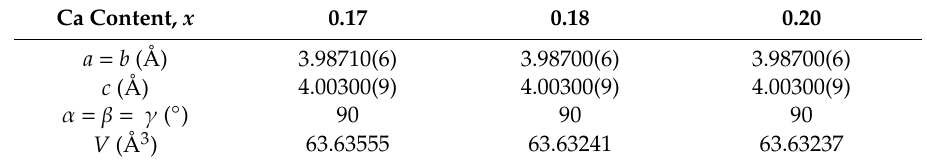
Figure 1. XRD (X-ray diffraction) pattern obtained for Ba 0.82 Ca 0.18 TiO 3 ceramics. Table 1. The refined cell parameters determined for tetragonal P 4 mm phase Ba 1 − x Ca x TiO 3 ceramics: x —Ca ion content, a , b , c and α , β , γ —crystal lattice parameters, and V —elementary cell volume.